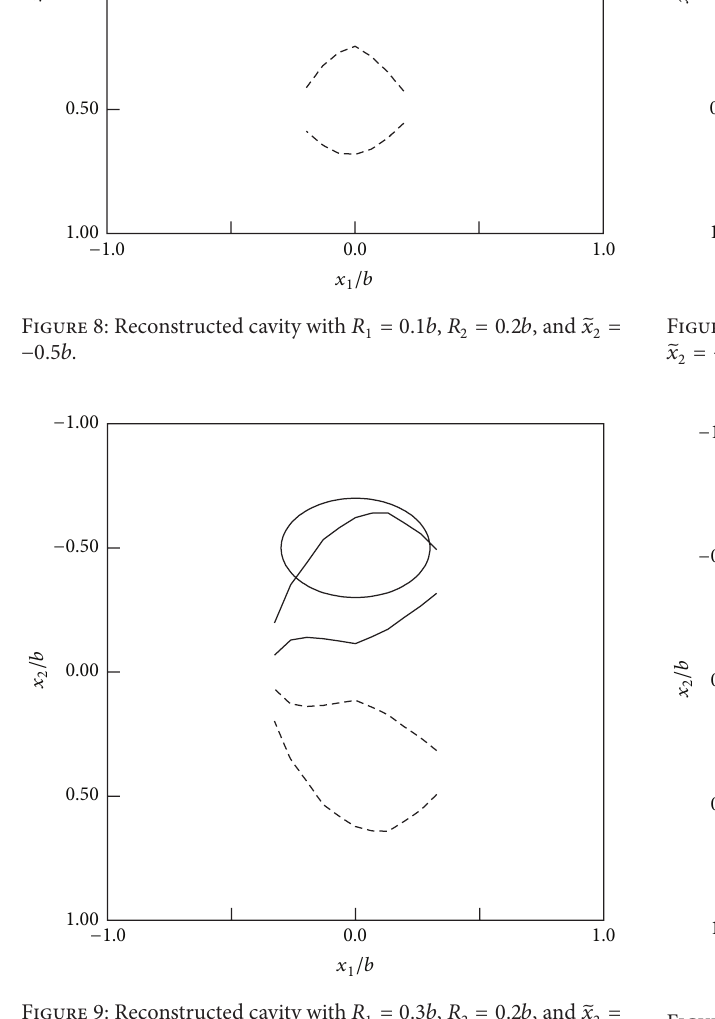
Figure 11: Reconstructed cavity with 𝑅 1 = 0.5𝑏 , 𝑅 2 = 0.2𝑏 , and ̃𝑥 = −0.5𝑏 2